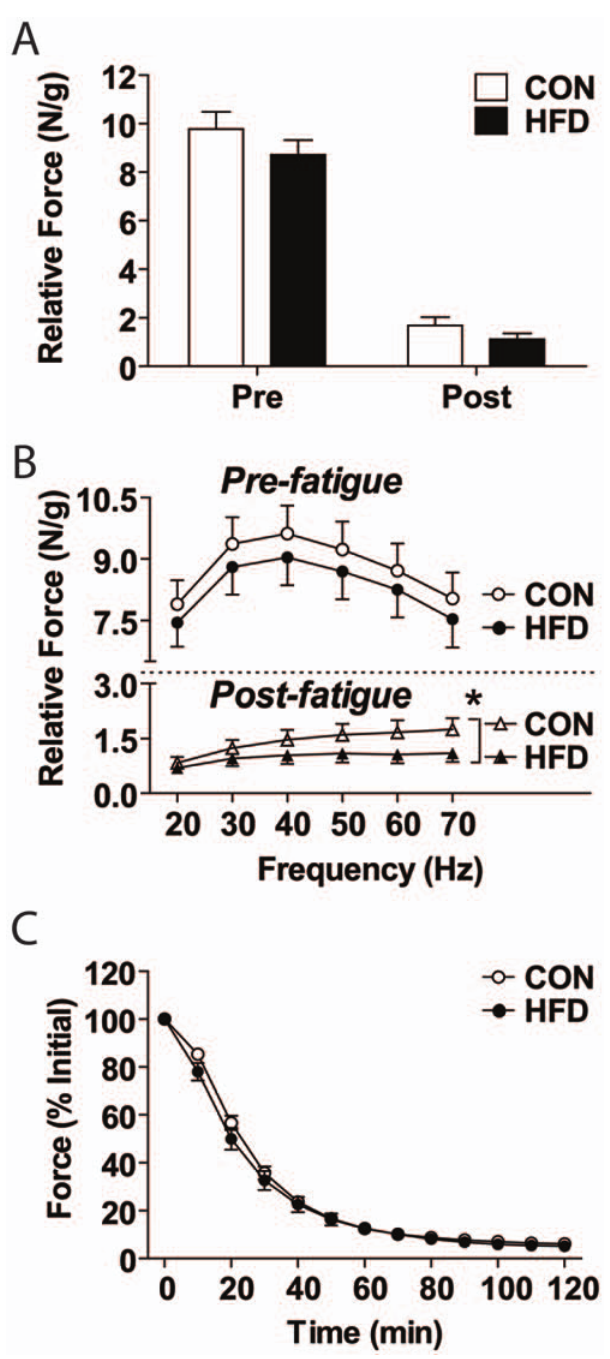
Figure 6. Insitu contractile analysis reveals trend towards force decrements, yet unaltered peak force and fatigue. Relative tetanic force production [in Newtons (N) per gram (g) of wet muscle mass] in the gastrocnemius/plantaris muscle group of high-fat diet (HFD) mice compared to control (CON) was (A) not different before (Pre) or after (Post) the fatigue protocol. (B) There was no difference between diets over all frequencies used to test force production pre-fatigue, however there was a significant main effect of diet post-fatigue. (C) Contractile force, relative to initial (% initial), throughout a 2 minute low-frequency fatigue protocol was not different between diet groups. Significance is represented by * vs. CON, p , 0.005.